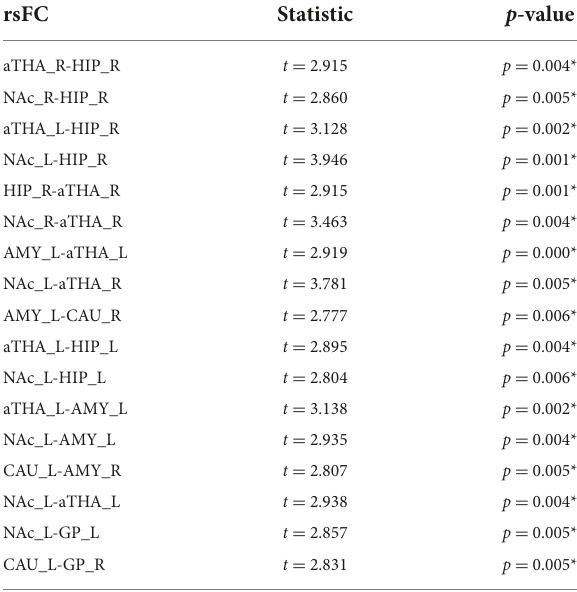
TABLE 2 Between-group differences in the